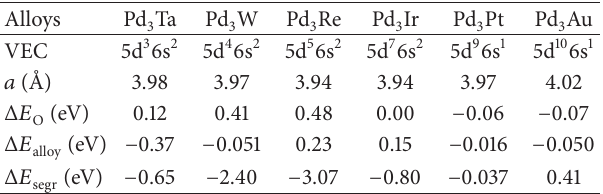
Table 3: The DFT calculated lattice constants, formation energies, Δ𝐸 (eV), surface segregation energies of Pd, Δ𝐸 alloy M (M is 5d transition metals) alloys, and adsorption various Pd 3 energies difference of O atom between Pd-segregated Pd (eV). Pt(111) surface, Δ𝐸 O